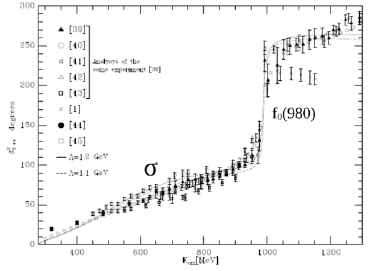
Figure 2. Isoscalar scalar ππ phase shifts, J PC = 0 ++ . For the experimental references see